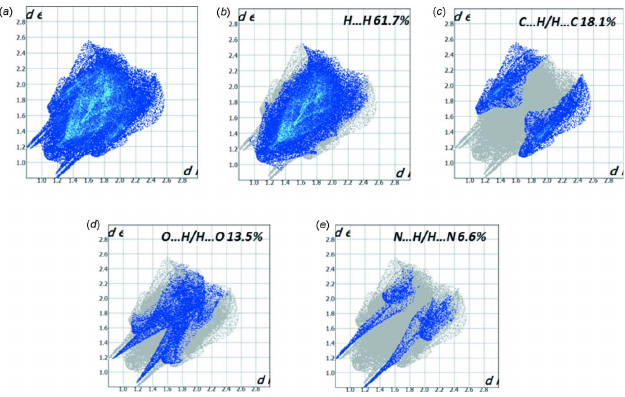
Figure 6 ( a ) The two-dimensional fingerprint plot for compound 4 , and those delineated into ( b ) H (cid:3)(cid:3)(cid:3) H (61.7%), ( c ) C (cid:3)(cid:3)(cid:3) H/H (cid:3)(cid:3)(cid:3) C (18.1%), ( d ) O (cid:3)(cid:3)(cid:3) H/ H (cid:3)(cid:3)(cid:3) O (13.5%) and ( e ) N (cid:3)(cid:3)(cid:3) H/H (cid:3)(cid:3)(cid:3) N (6.6%) contacts.